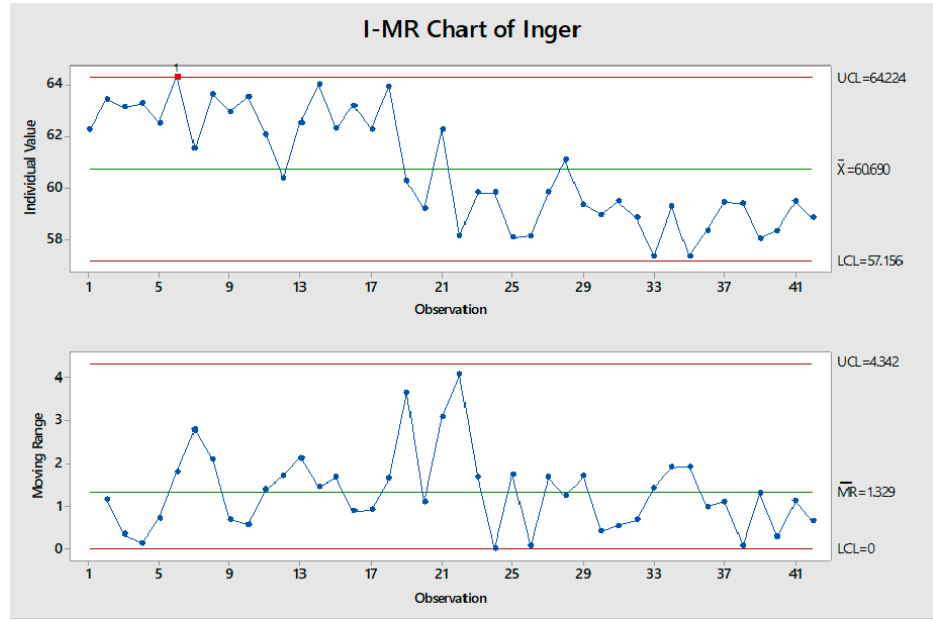
Figure 4. Survival rate of the Inger clone on contaminated land.